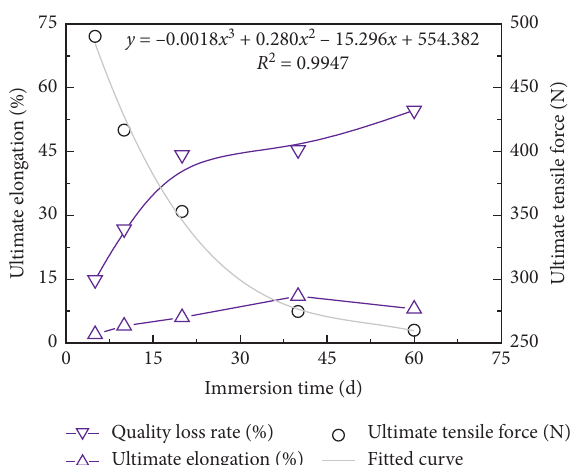
Figure 7: Ultimate tensile force, elongation, and mass loss rate with immersion